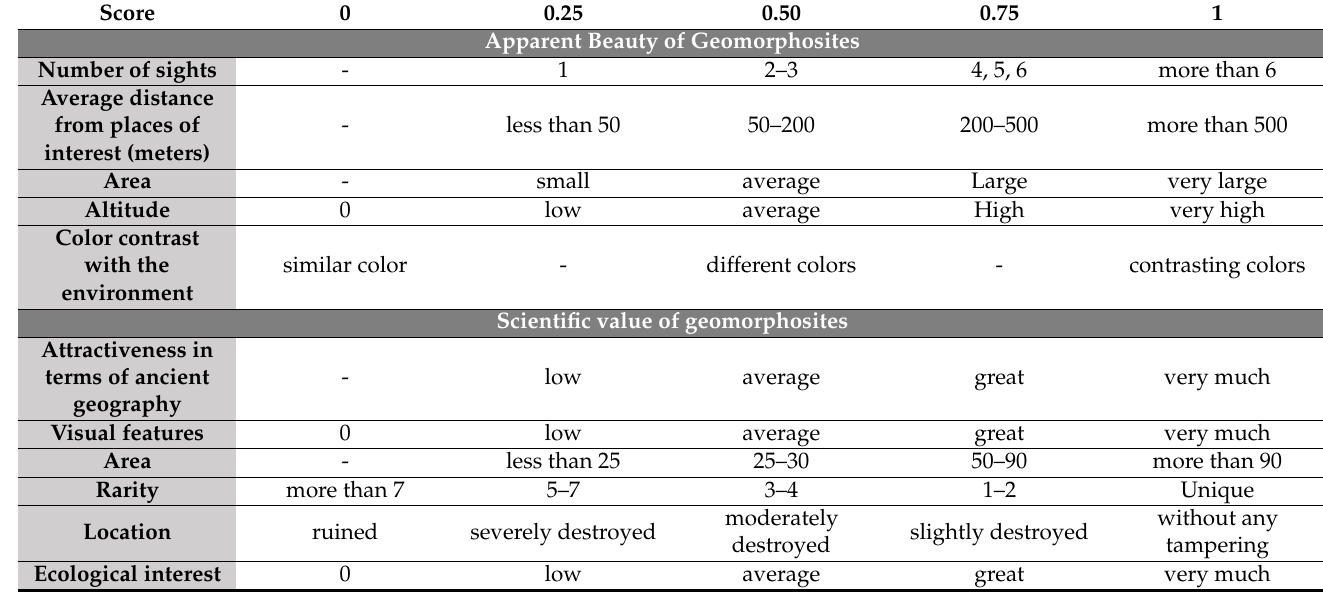
Table 4. Evaluation of the four geomorphotourism criteria based on the Pralong